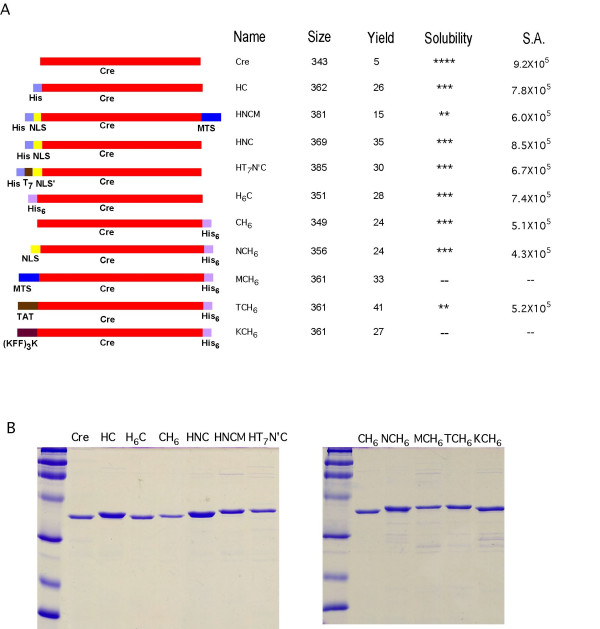
Recombinant Cre fusion proteins. (A) Structures of recombinant Cre fusion proteins. Cre sequences from nucleotide 484 to 1513 (GenBank X03453) were expressed unaltered or incorporated into fusion proteins containing one or more of the following elements: His (MGSSHHHHHHSSLVPRGSH); His6 (MHHHHHH or HHHHHH for N- and C-terminal sequences, respectively); NLS (PKKKRKV); NLS' (PKKKKKV); T7 (MASMTGGQQMG); MTS (AAVLLPVLLAP); TAT (YGRKKRRQRRR) and (KFF)3K (KFFKFFKFFK). The table on the right lists the name, size (number of amino acids), yield following purification from E. coli (mg/L), relative solubility, and in vitro specific activity (units per milligram of enzyme) of each fusion protein. (B). Analysis of purified Cre fusion proteins. Purified Cre fusion proteins were fractionated by SDS-PAGE and stained with Coomassie blue.